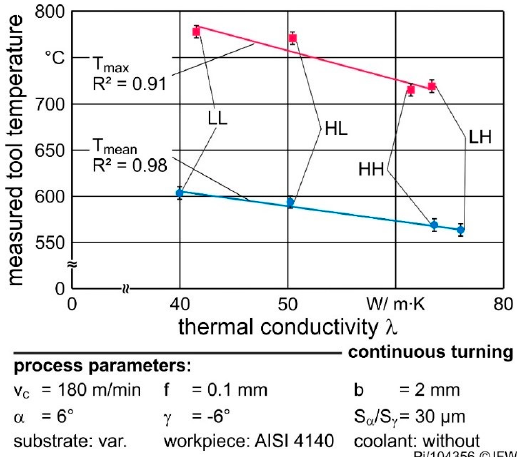
Figure 9. Relation between mean and maximum tool temperatures and the cemented carbide thermal conductivity (continuous cutting, v c = 180 m / min, cutting edge rounding S α = S γ = 30 µ